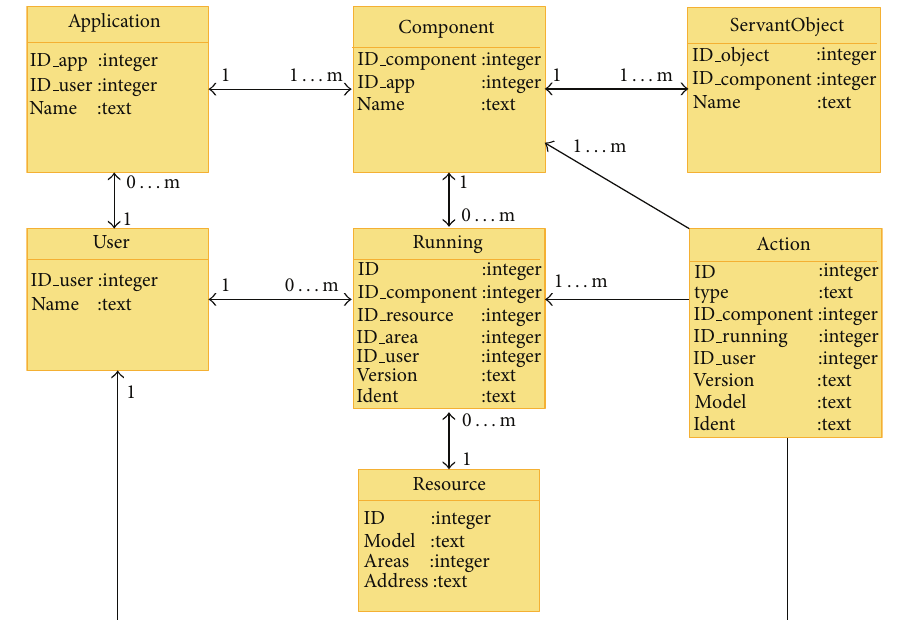
Figure 4: Database relational